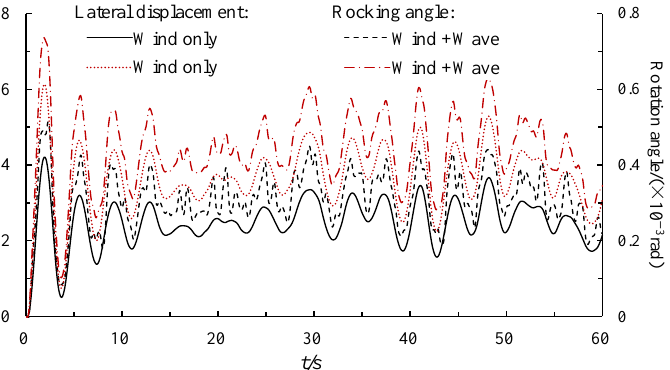
Figure 23. Comparison of the dynamic response of the GBF under wind load and combined loads.